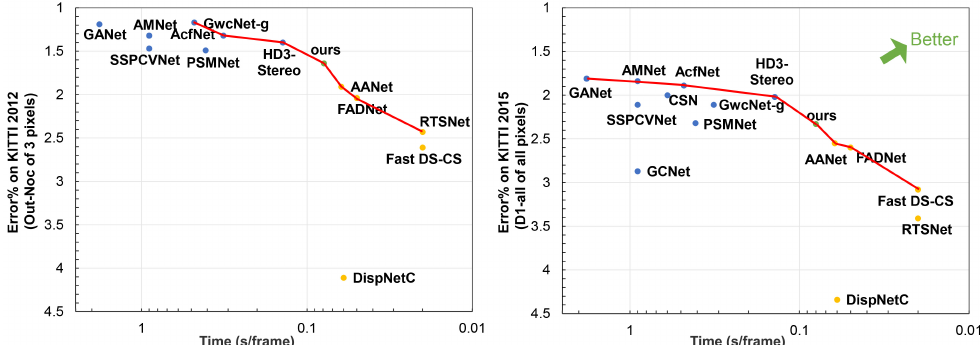
Figure 6. The visualization of pareto front for recent stereo methods. Blue dots represent accurate 3D networks, while yellow dots represent fast 2D networks. The green dot is our proposed method. Our method are the non-dominated solutions for both KITTI 2012 and KITTI 2015. Meanwhile, compared with other fast non-dominated solutions (AANet, FADNet, etc.), our method has the highest accuracy, demonstrating the effectiveness of our proposed